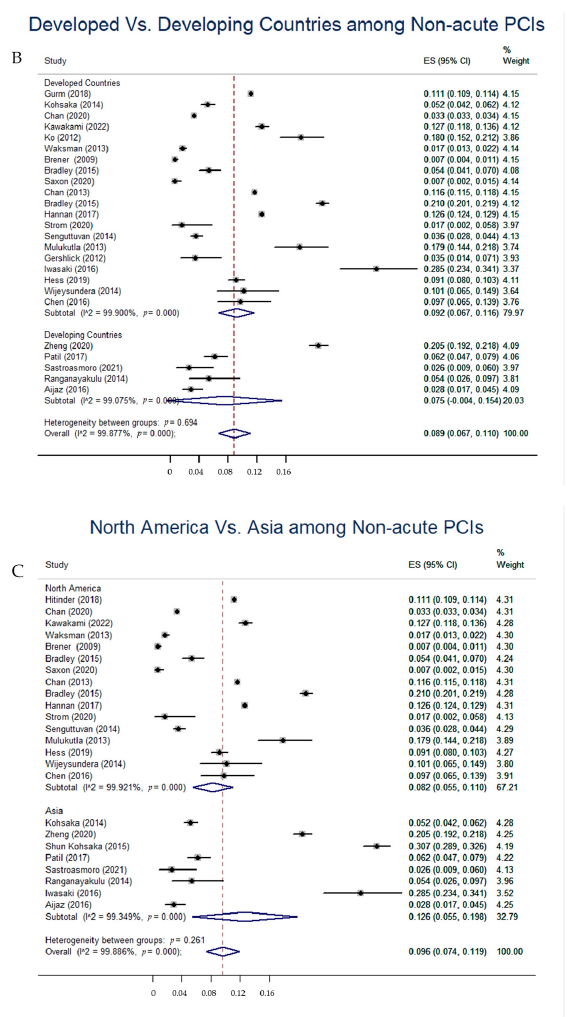
Figure 3. Subgroup analyses for the heterogeneity of included studies. ( A ) Inappropriate PCI rate between CTO patients and other non-acute PCI patients. ( B ) Inappropriate non-acute PCI rate in developed countries and developing countries. ( C ) Inappropriate non-acute PCI rate in North America and